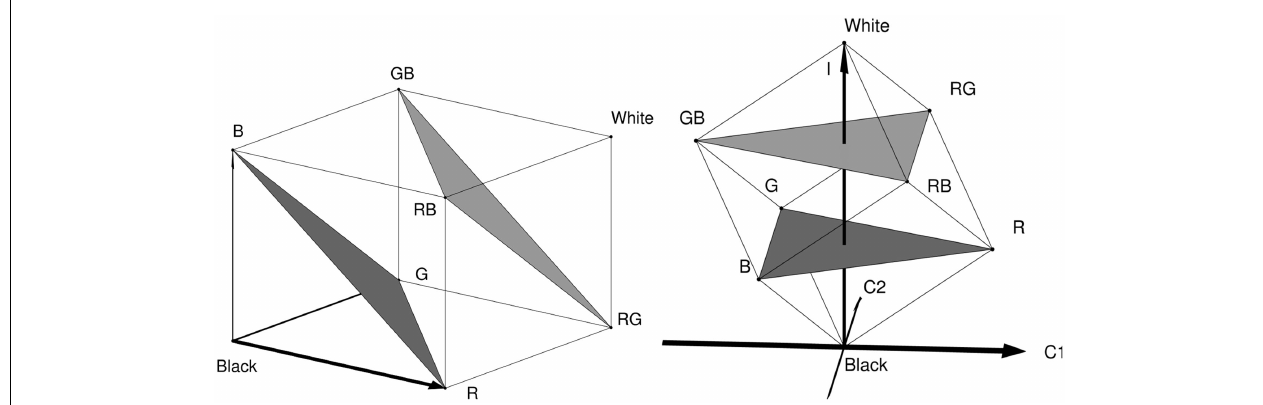
FIGURE 3 | Illustration of the color opponent transform (Åström, 2015) . Figure courtesy Freddie Åström.